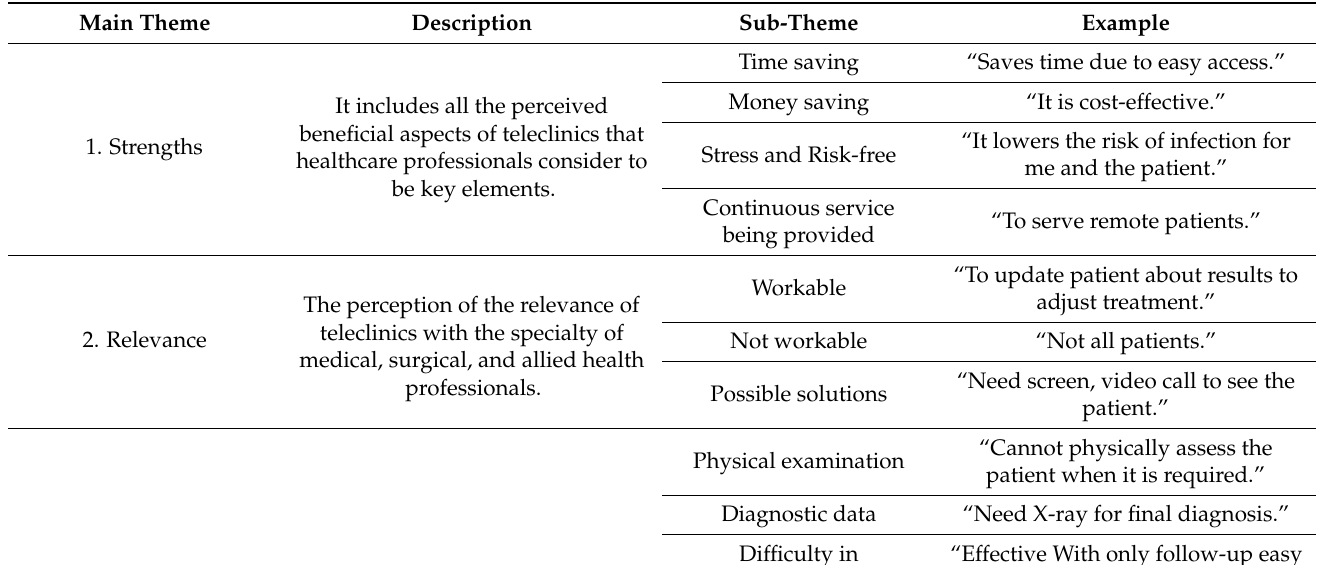
Table 6. Main and sub-themes of the qualitative